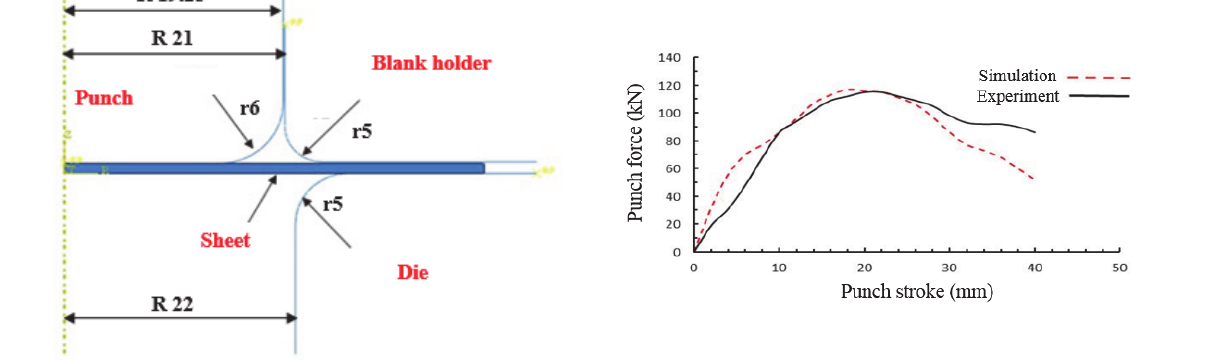
Fig. 3. Good agreement of simulation results with experimental results of punch force (Modanloo et al.,